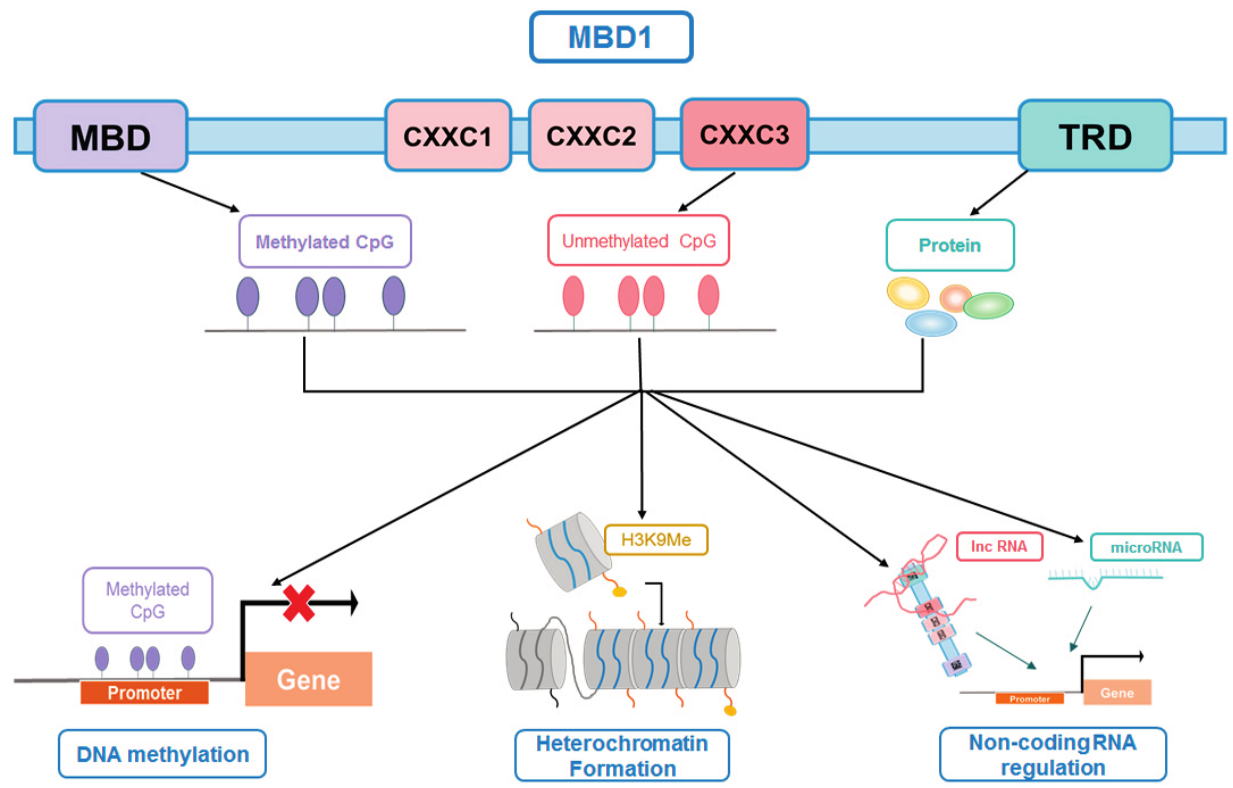
Figure 2. Structure of methyl-CpG-binding domain protein1 (MBD1) and the basic mechanism of MBD1 epigenetic